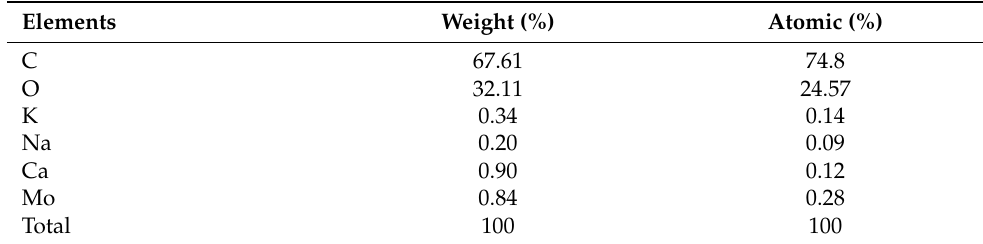
Table 3. Elemental composition of AG.